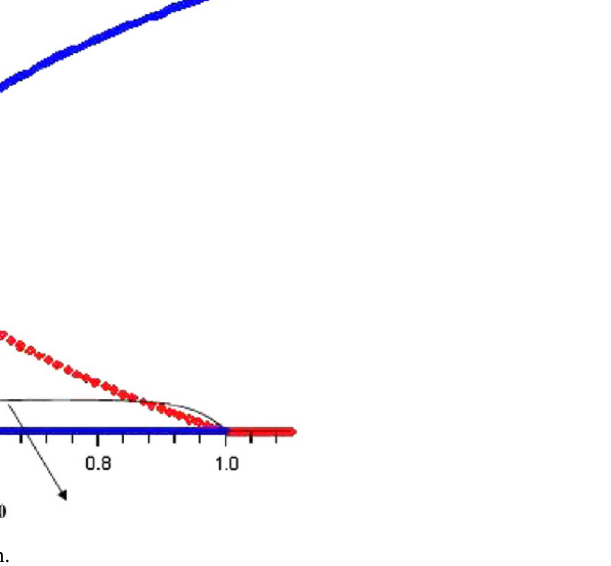
Figure 5. Backward